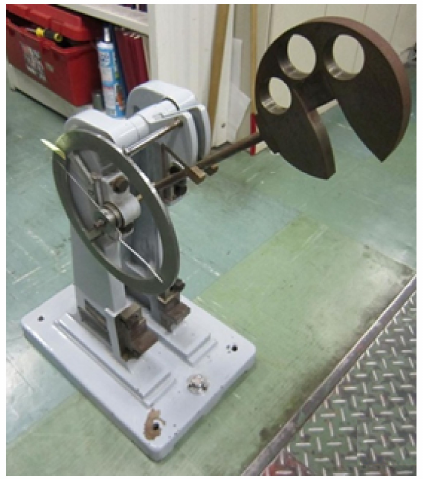
Figure 3. Charpy impact